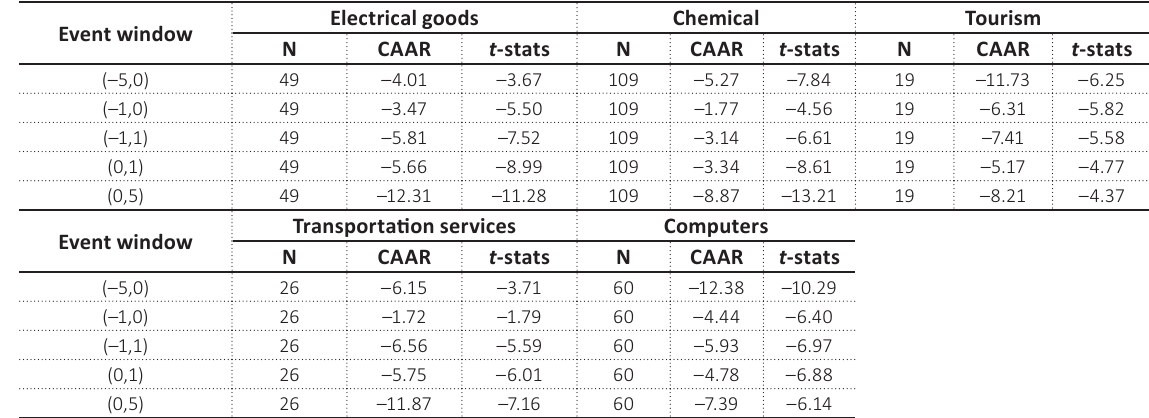
Table 5. CAAR for the electrical goods, chemical, tourism, transportation services, and computers sectors to show the impact of the COVID-19 outbreak in different event windows Electrical goods Event window